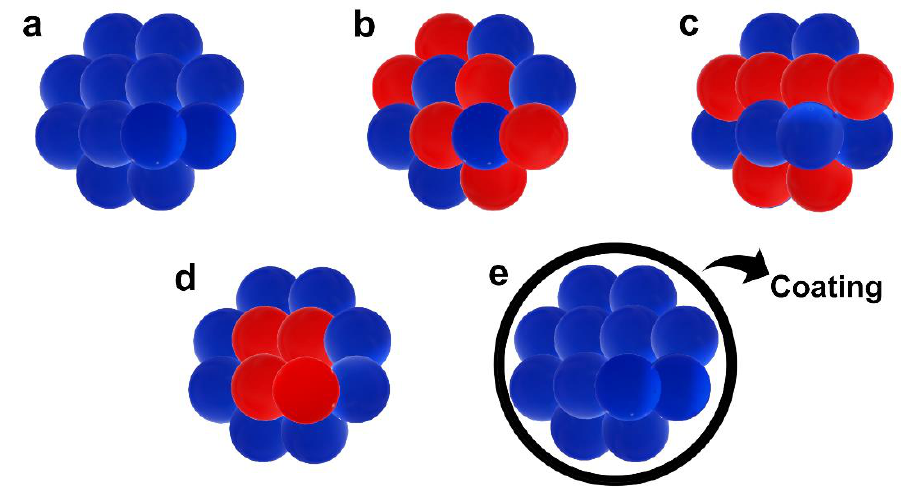
Figure 12. Common Pt-based NPs: ( a ) a simple metallic NP, ( b ) a random bimetallic NP, ( c ) an ordered bimetallic NP, ( d ) a core – shell NP and ( e ) a coated or encapsulated metallic NP.